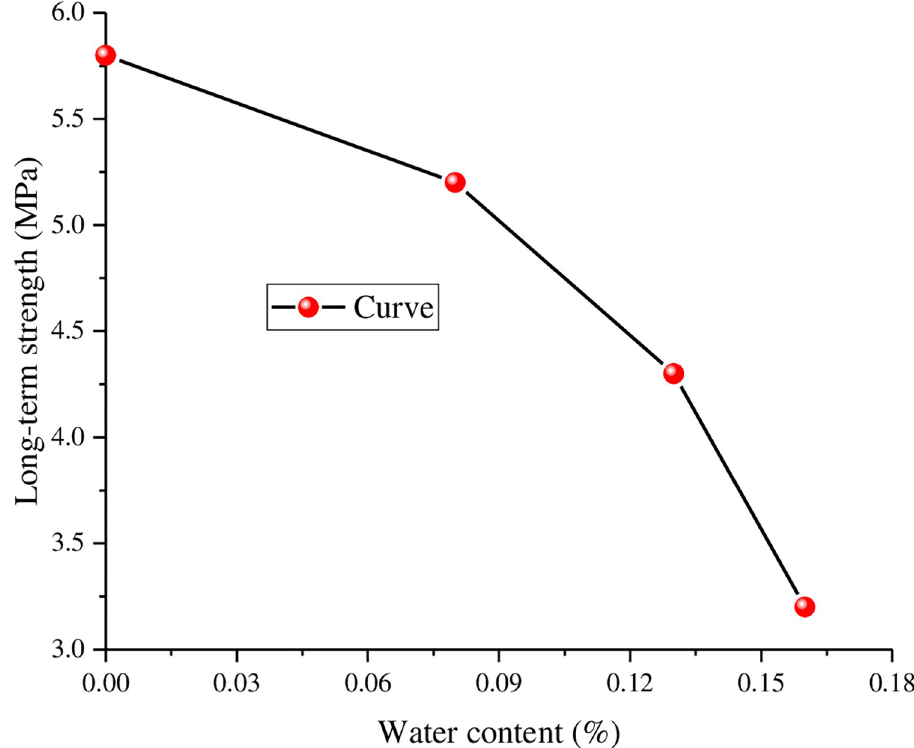
Fig 7. Curve of long-term strength with water